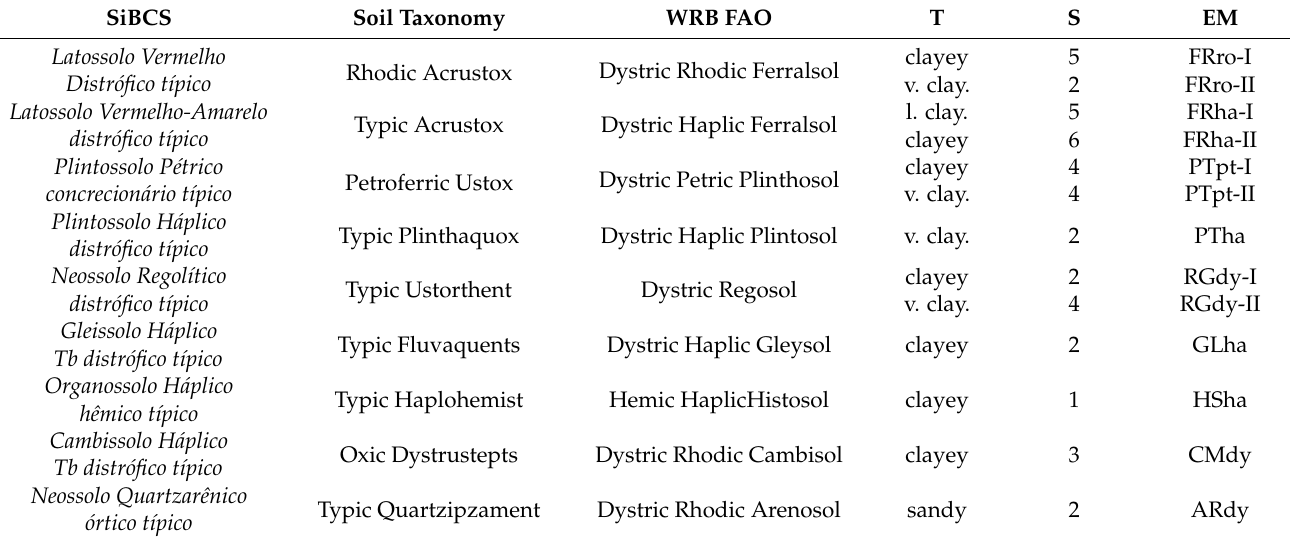
Table 3. Classification of soils in the study